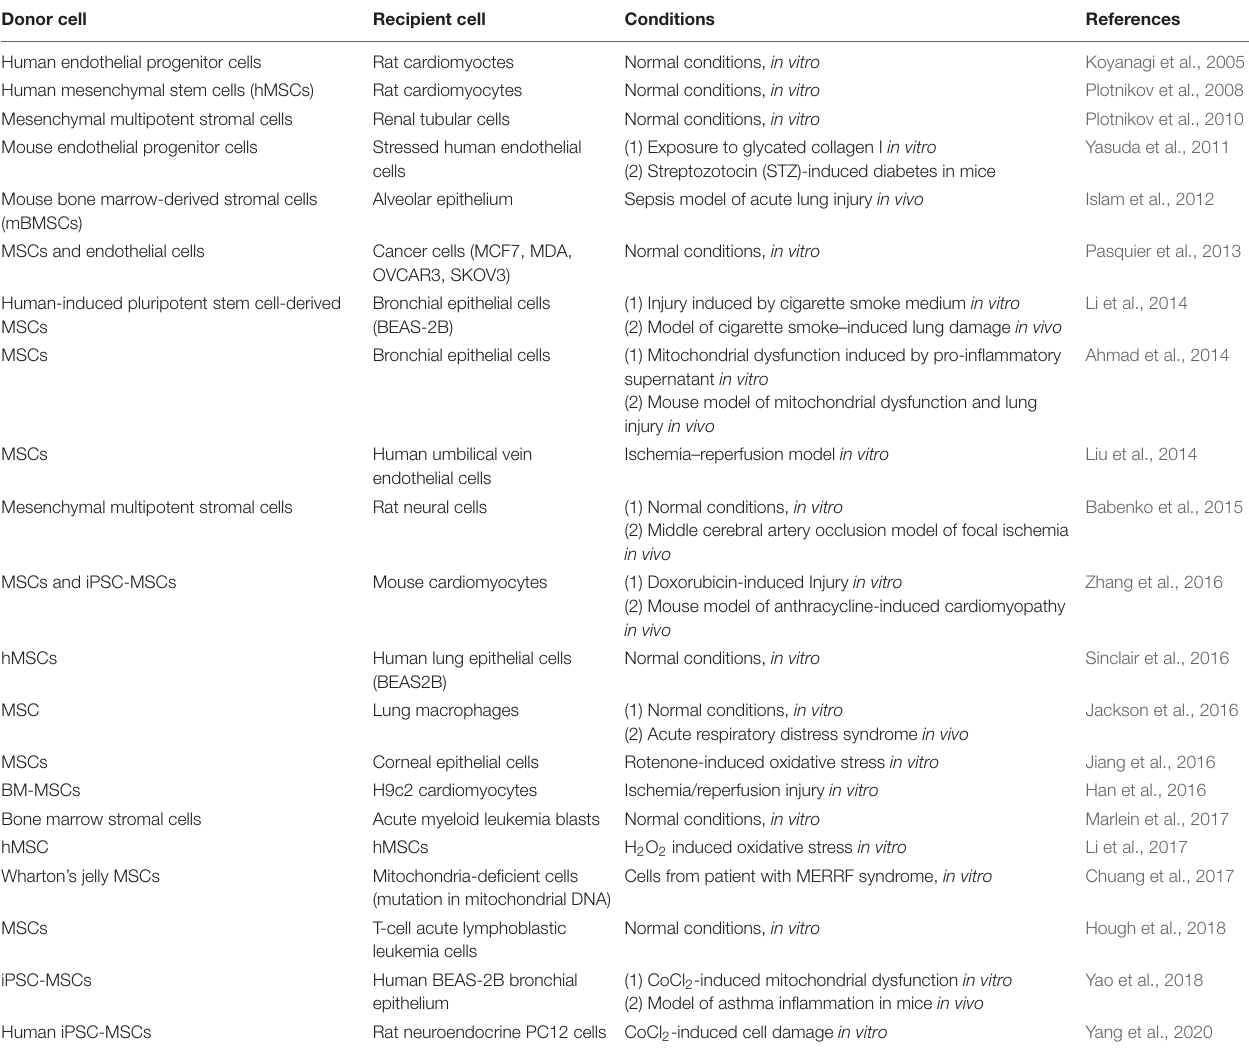
TABLE 1 | Studies demonstrating TNT-mediated mitochondria